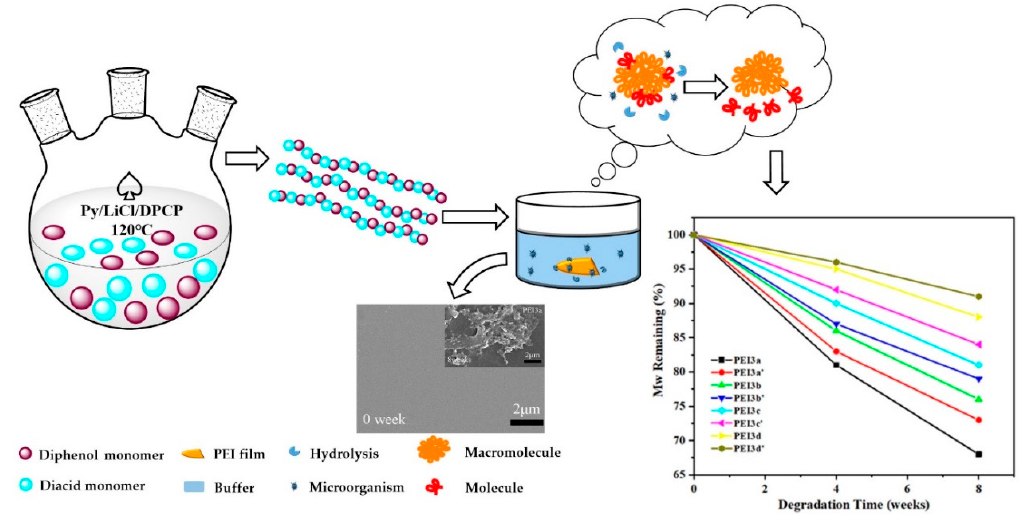
Figure 1. The synthesis and degradation of polyester-imide (PEI).